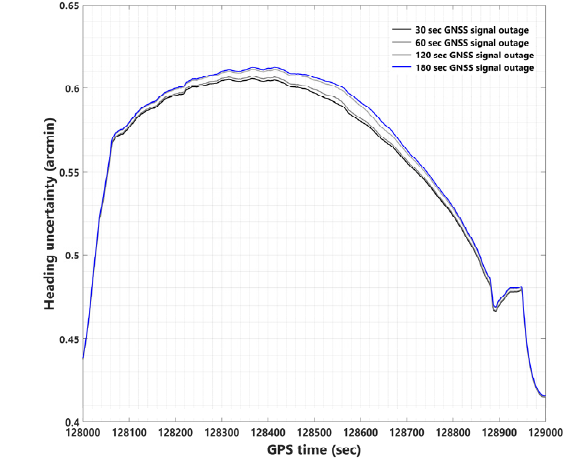
Figure 10. Uncertainties of heading using smooth processing and assuming different GNSS signal